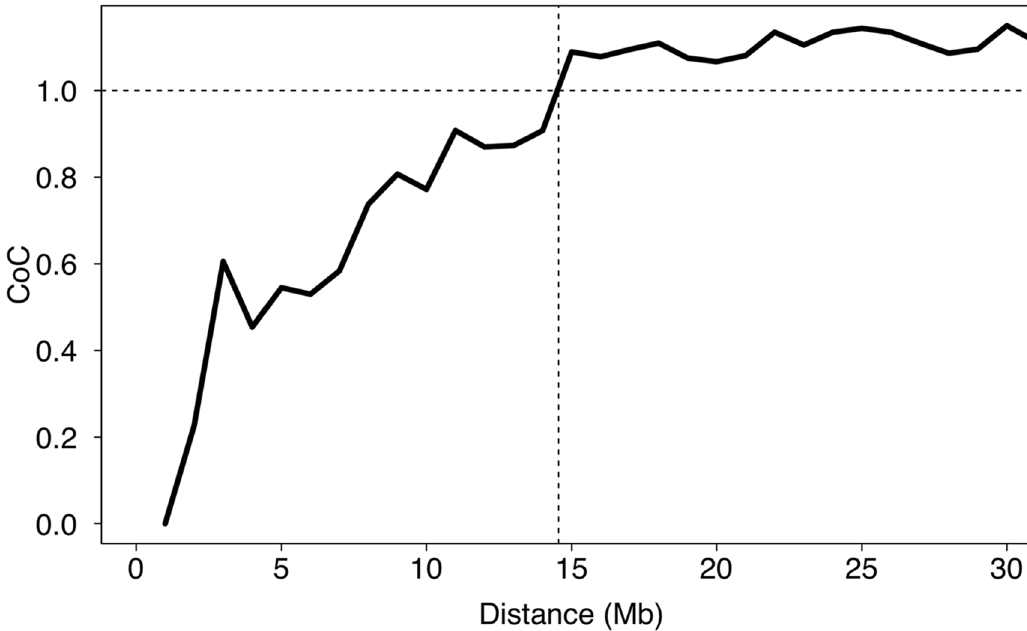
Fig 4. Mean crossover interference in relation to the distance of double crossovers. Interference was measured as the coefficient of coincidence (CoC). The horizontal dashed line at a CoC of 1 indicates an interference of